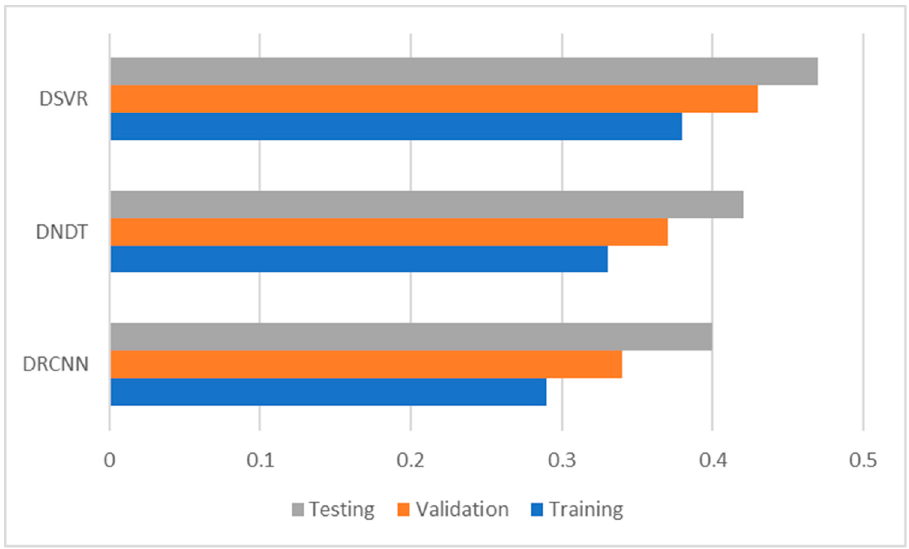
Figure 3. Results of accuracy evaluation: MAPE. Table 4. Results of accuracy evaluation: greater sensitivity variables.